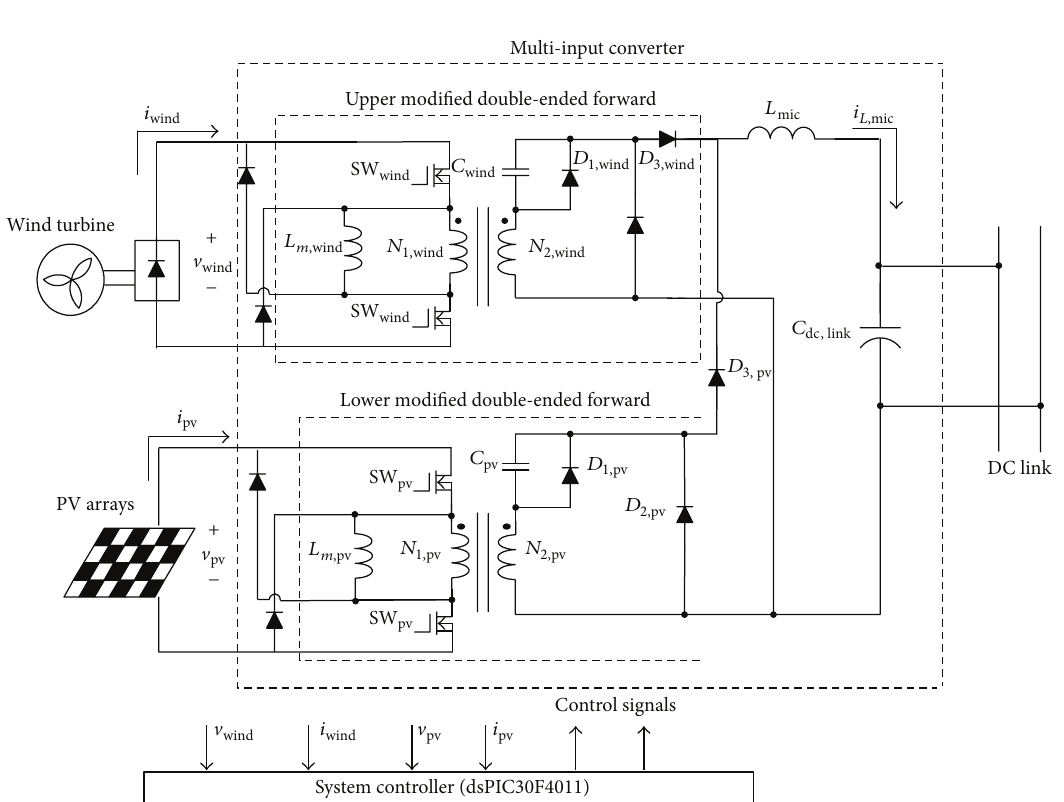
Figure 5: The proposed multi-input converter to process PV-wind